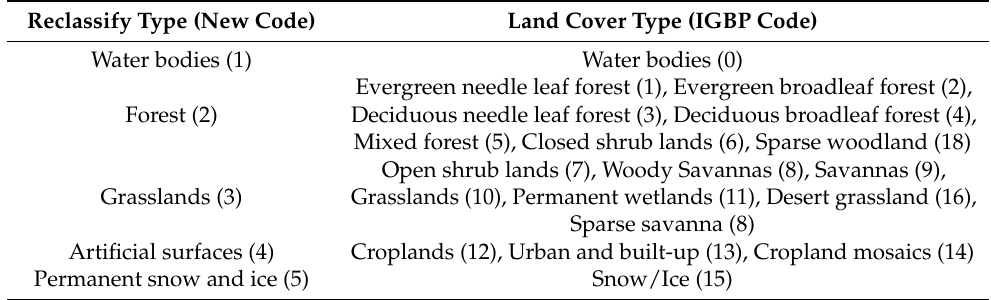
Table A1. Reclassified scheme of the MCD12Q1 land cover product.